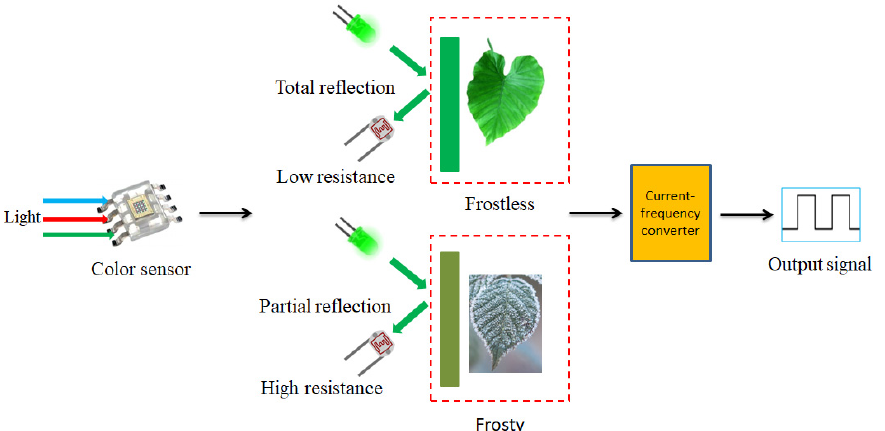
Figure 13. Detecting frost formation principle on plant surface based on color sensing theory.